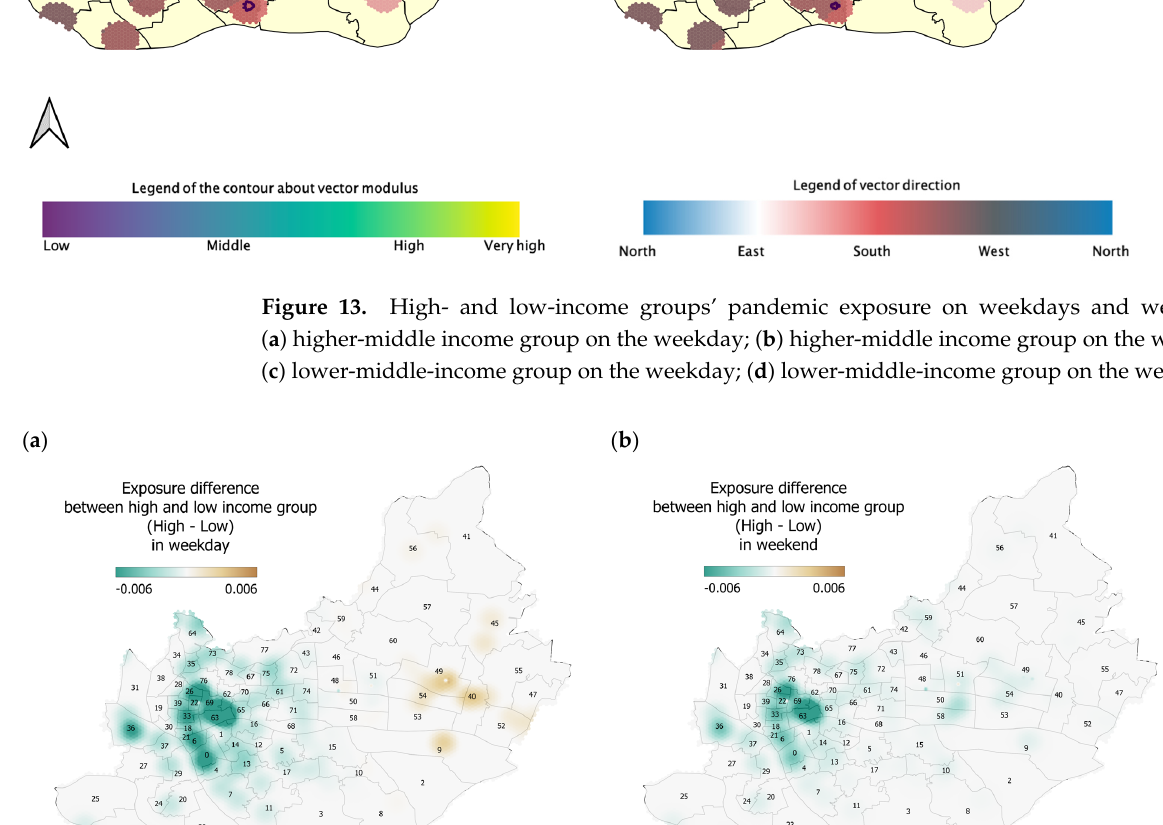
ISPRS Int. J. Geo-Inf. 2022 , 11 , x FOR PEER REVIEW